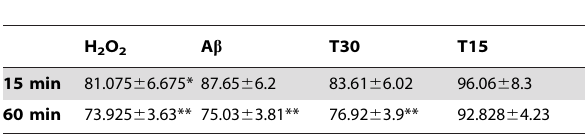
Table 1. Representative table of cell viability (% of Control) after 15 and 60 minutes treatments with Hydrogen peroxide (H 2 O 2 ) 100 m M, b -Amyloid (A b ) 0.7 m M, AChE C-terminus peptides of 30 amino acids (T30) 0.7 a M and the residual 15 amino acid sequence (T15) 0.7 a M. Data are presented as the percentage of the mean 6 S.E.M. from five independent experiments carried out on triplicates (N